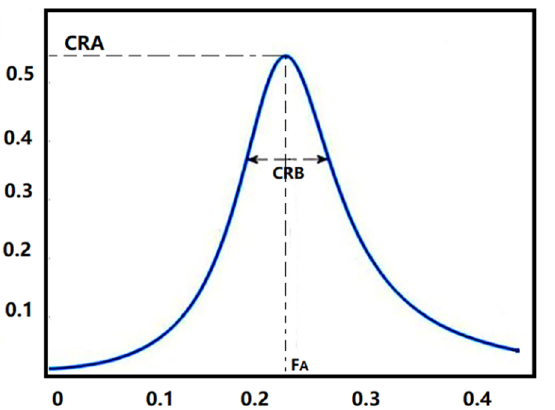
Figure 3. Cardiopulmonary Resonance Indices (CRI). CRA is the maximum amplitude of the curve, and CRB is the bandwidth of the curve. F A is the cardiopulmonary resonance frequency.